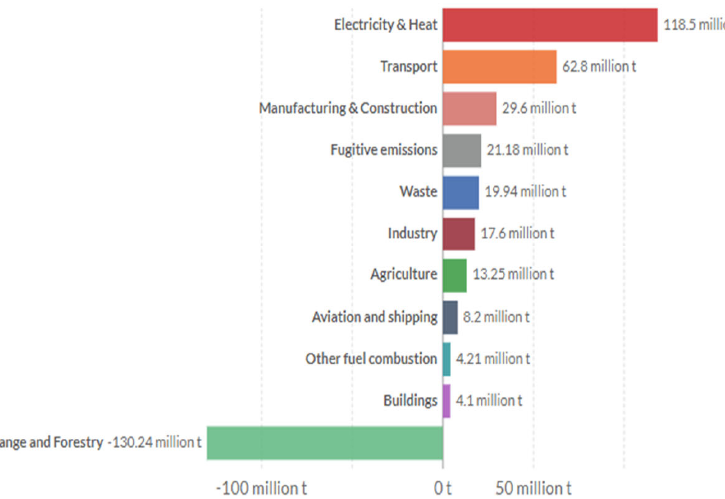
Figure 1. Greenhouse-gas emission by sector in Malaysia in 2016 [2].